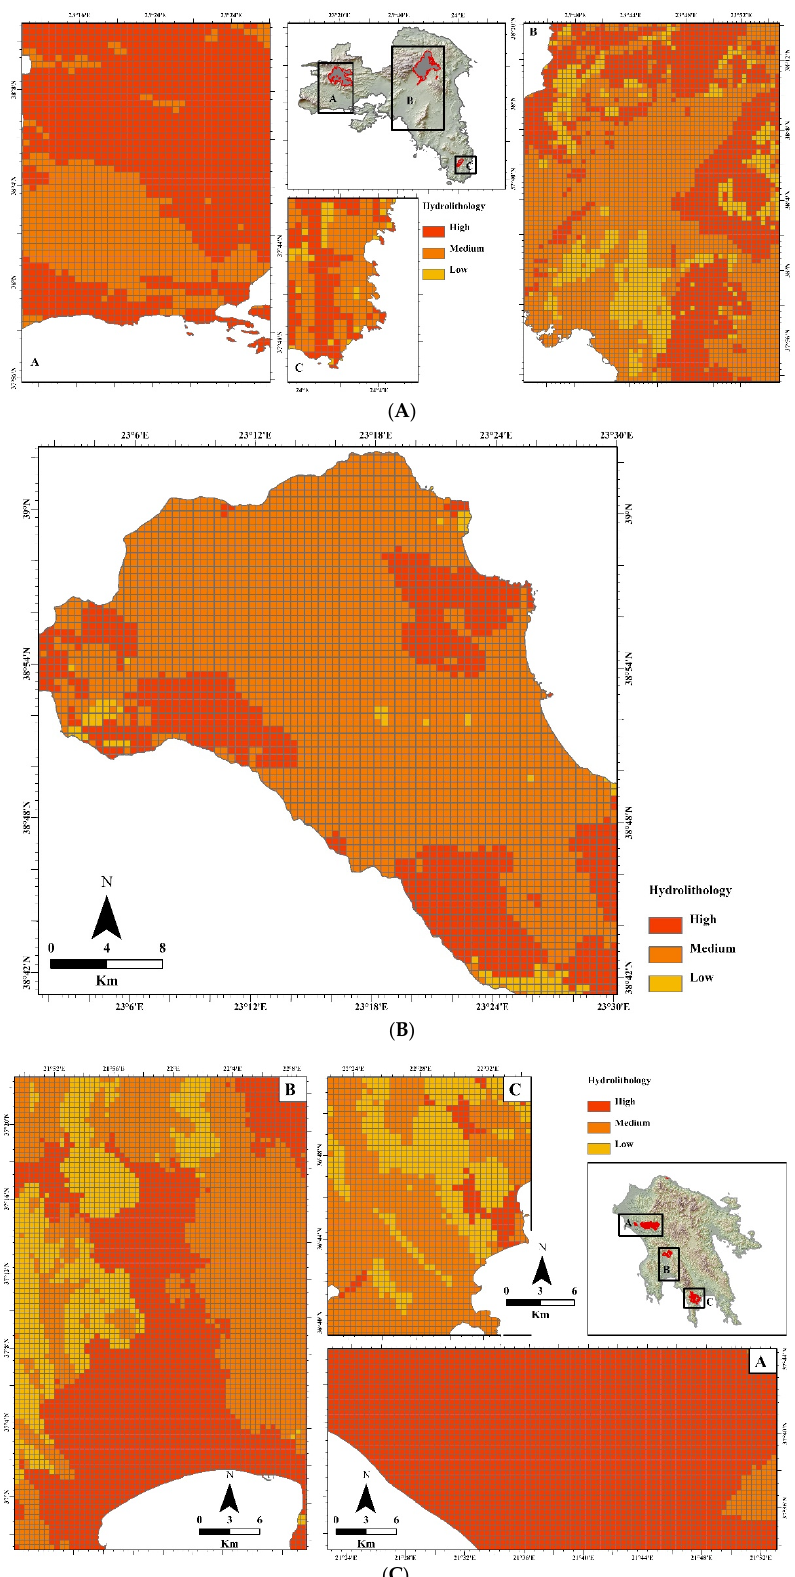
Figure 10. Classification of hydrolithology into three values: ( A ) Attica, ( B ) Euboea, and ( C ) Peloponnese. Table 1. Parameters used for the assessment of flash flood hazard and their relationships. The background color follows the color plate of the map: green (low hazard), yellow (medium hazard), orange (high hazard) and red (very high hazard).